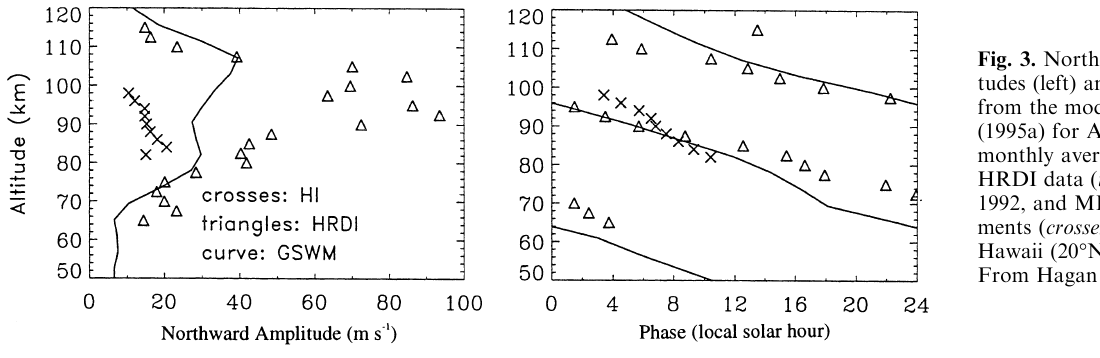
Fig. 3. Northward wind ampli- tudes (left) and phases (right) from the model of Hagan et al . (1995a) for April at 21 (cid:176) N and monthly averaged UARS/ HRDI data ( triangles ) for April 1992, and MF radar measure- ments ( crosses ) over Kauai, Hawaii (20 (cid:176) N), for April 1992. From Hagan et al